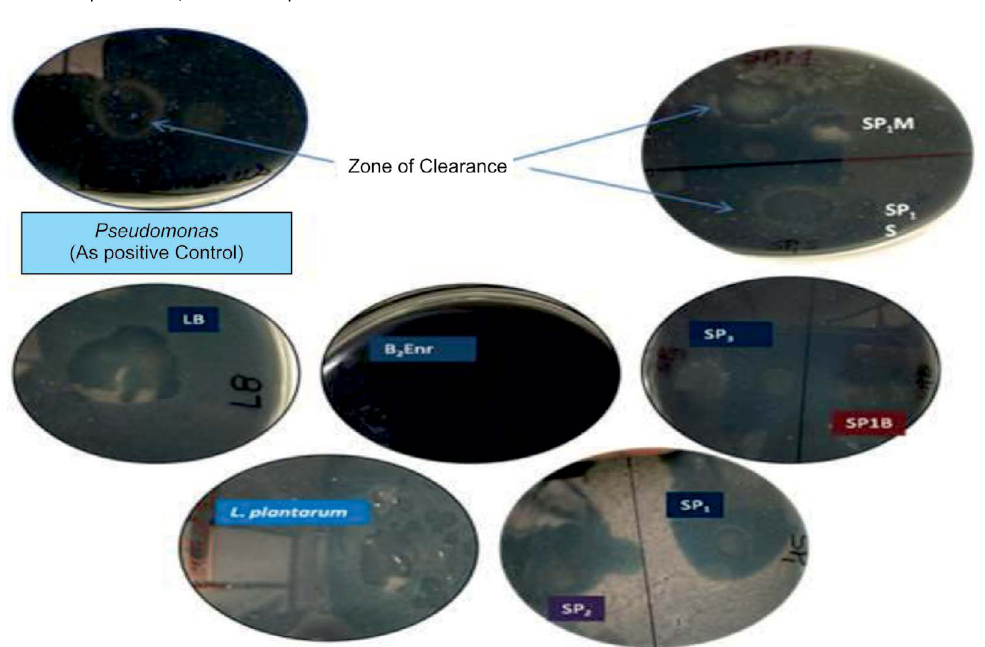
Fig. 1. Mucin degradation by probiotic isolates: SP1M and SP1S showed mucin degradation as observed by clear zone around the colonies. Pseudomonas aruginosa was used as positive control for mucin